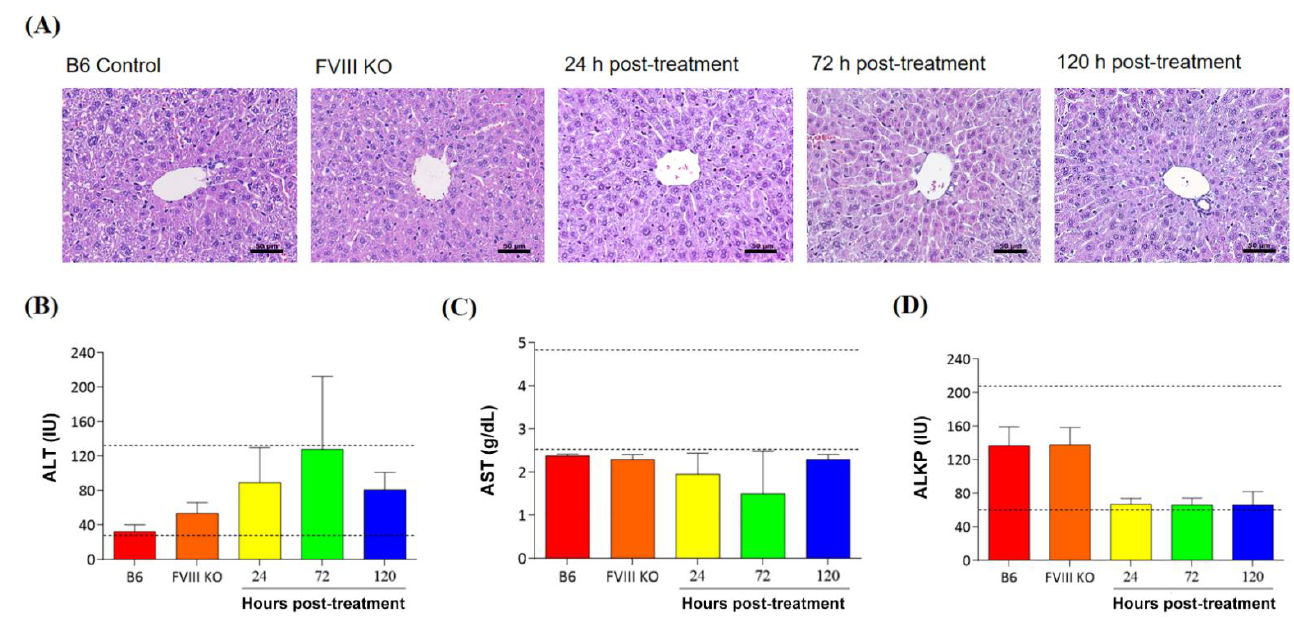
Figure 7. Verification of the side effects after delivery of the DPPC-Fe 3 O 4 -plasmid complex to the liver tissue of mice with hemophilia A. ( A ) The recipient mice were sacrificed at 24 h (n = 3), 72 h (n = 3), and 120 h (n = 3) after delivery of the DPPC- Fe 3 O 4 -plasmid complex, and the histopathological changes in H&E-stained liver sections were analyzed. C57BL/6 mice (n = 6) were used as a normal control, and FVIII knockout mice (n = 6) without DPPC-Fe 3 O 4 -plasmid complex injection were used as an untreated control. Images were obtained at 40× magnification, scale bar = 50 µm. Serum biochemical parameters for liver indices, including ALT ( B ), AST ( C ), and ALKP ( D ), were measured in the normal C57BL/6J control mice, FVIII knockout mice without treatment, and FVIII knockout mice treated with the DPPC-Fe 3 O 4 -plasmid complex at different time points (24 h, 72 h, and 120 h after gene therapy). The dashed lines show the normal range of each parameter in normal mice. Data are presented as the mean ± SD.